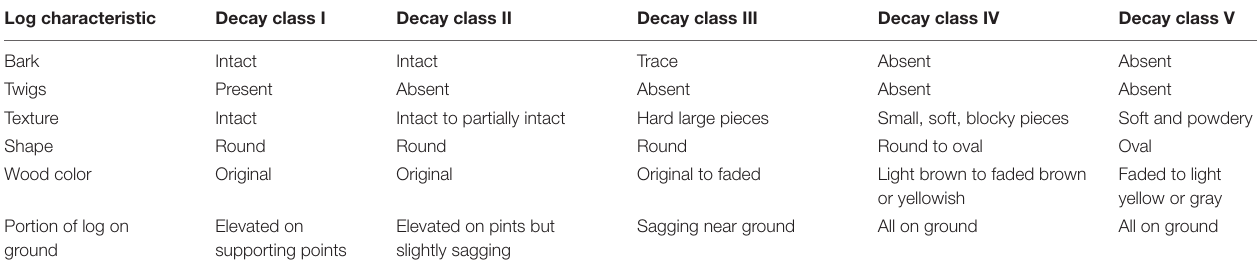
TABLE 1 | The log decay classification characteristics used in this study were reproduced from Maser et al.